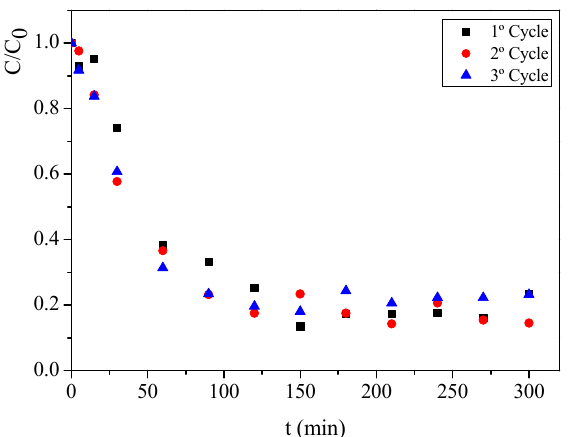
Figure 11. Relative PY concentration, C/C 0 , as a function of time for FeCu-NaY for three cycles